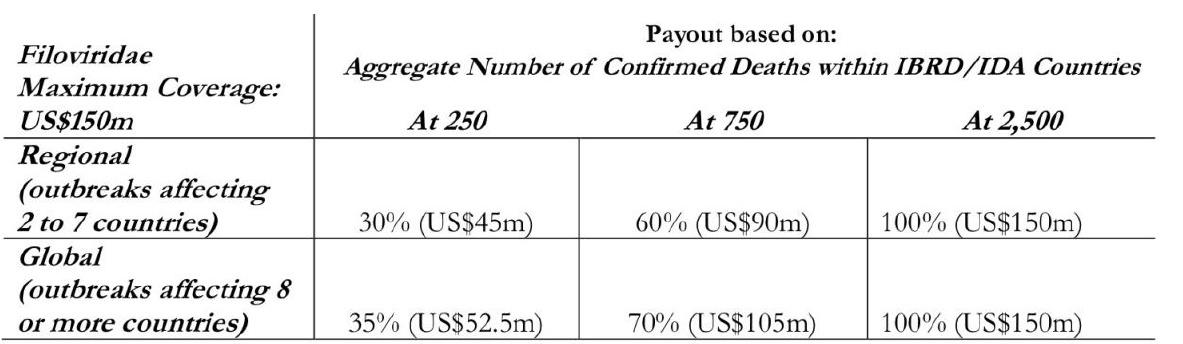
Table 1. World Bank table showing pandemic payout amounts for